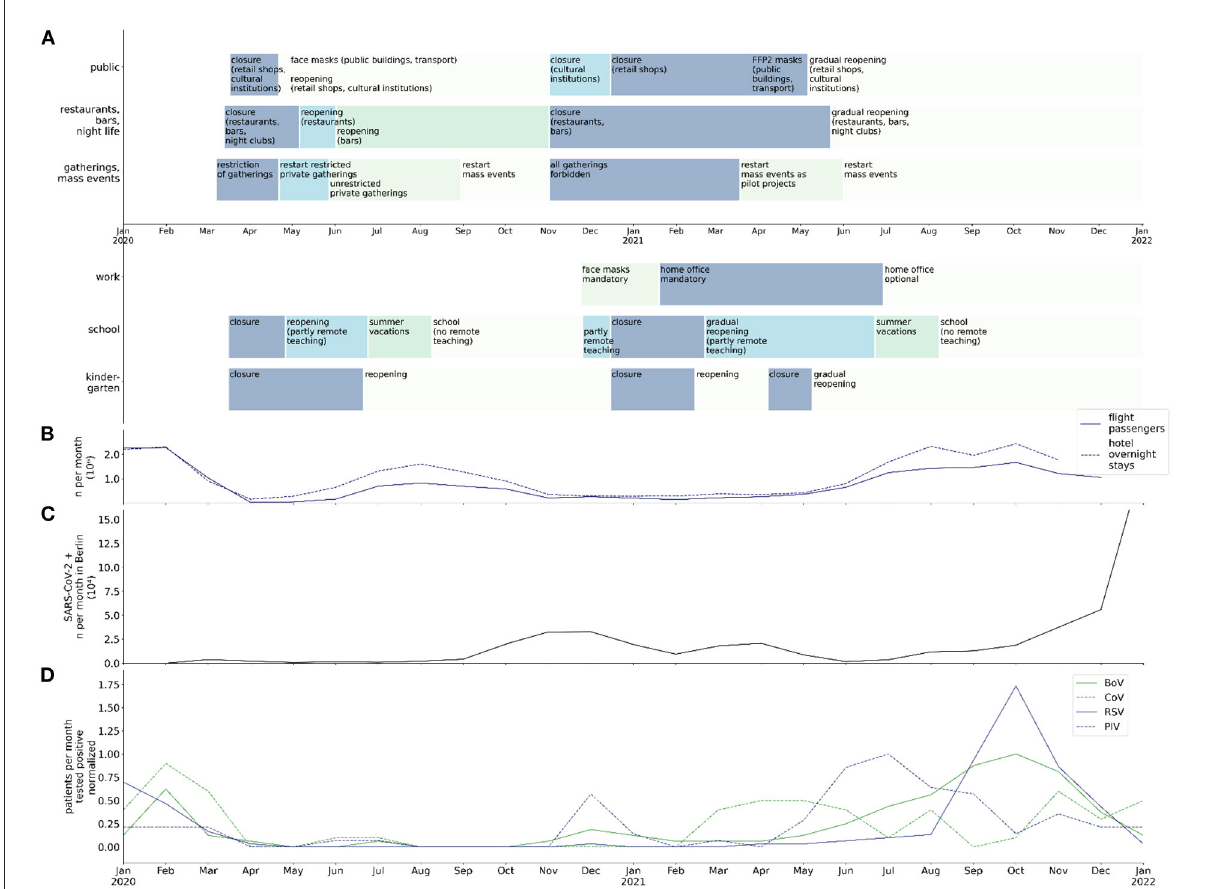
FIGURE1 Chronology of NPI, traveling, SARS-CoV-2 detection rate in Berlin, and normalized virus detection rate at BCH between January 2020 and January 2021; (A) chronology of public regulations in public buildings/spaces, restaurants and night life, private and public gatherings, workplace, school, and kindergartens in Berlin; (B) numbers (10 6 ) of flight passengers and overnight stays in hotels per month in Berlin; (C) rate of SARS-CoV-2 infections (10 4 per month) in Berlin; (D) max-normalized rate of infections (per month) with BoV, CoV, RSV, and PIV in hospitalized patients at